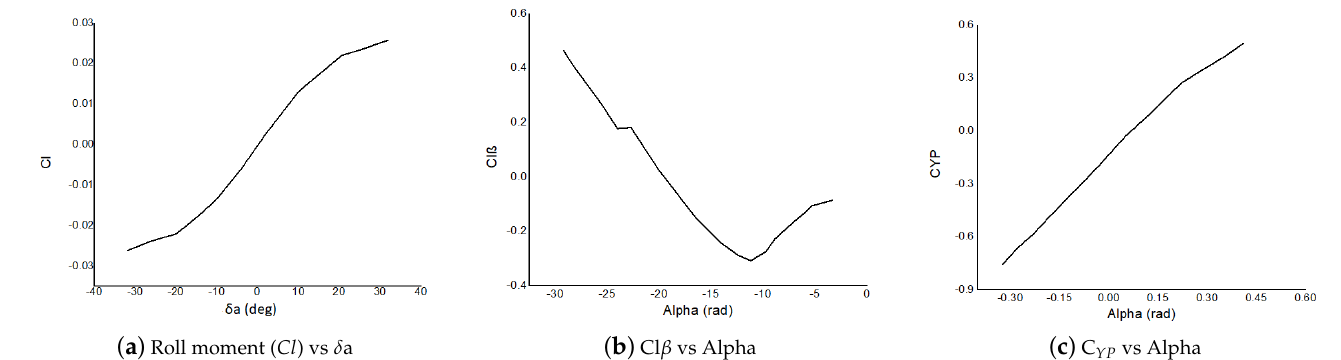
Figure 7. Analysis of lateral aerodynamic coefficients for different angle of attack ( a ) Variation of roll moment coefficient with aileron deflection; the figure shows an increase in roll moment coefficients with positive aileron deflection and vice versa for the other side. ( b ) Variation of roll moment coefficient with angle of attack; the figure shows the negative slope of Cl β , satisfying the roll stability requirement for the range of the angle of attack. ( c ) Variation in the side force coefficient due to roll rate; the figure shows an increase in side force with an increase in roll